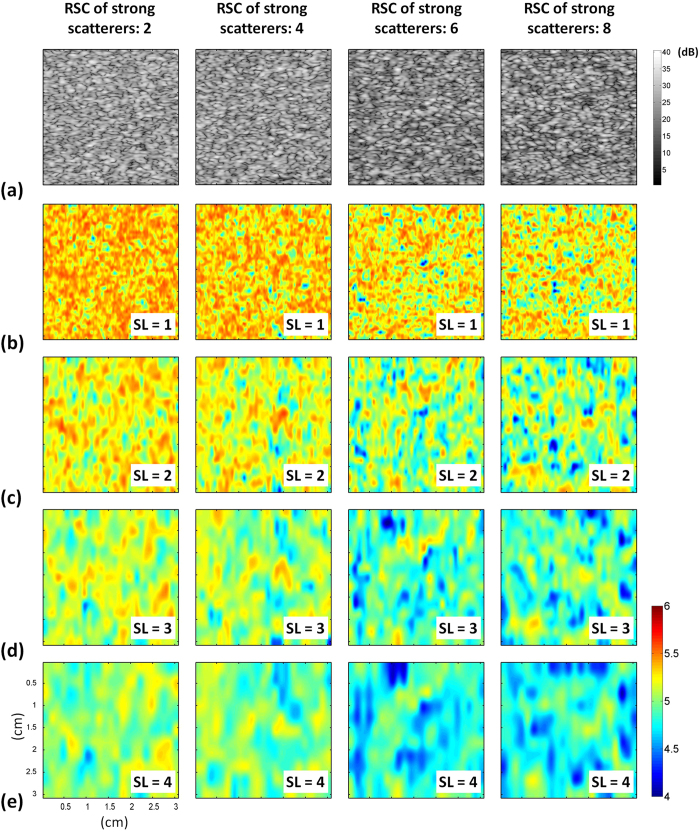
(a) B-mode and (b–e) entropy images of Type-II simulated phantoms containing strong scatterers with different RSCs constructed using different SLs. (b) SL = 1; (c) SL = 2; (d) SL = 3; (e) SL = 4. The dimensions for all images are the same. The grayscale and color bars represent the pixel values (the brightness) of the B-mode and entropy images, respectively. The change in the shade of the entropy images showed a decrease in the entropy because of the increasing phantom inhomogeneity.